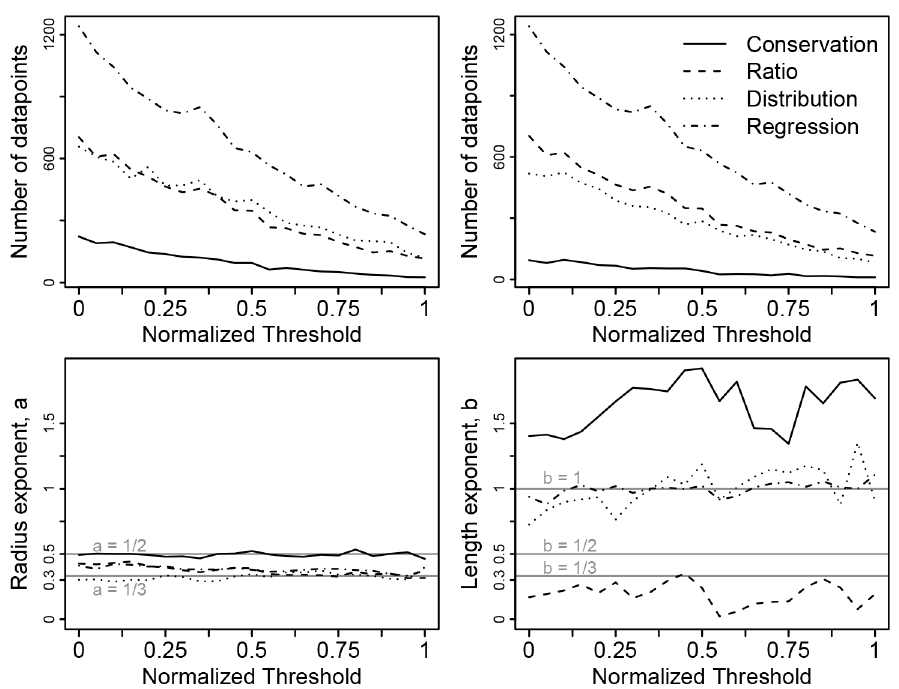
Fig 5. Sensitivity of the measured scaling exponents to the threshold intensity values that select which voxels are part of the vessel lumen. We normalized the threshold so that the minimum threshold (0.0) is the value used in our results and figures above, while the maximum threshold (1.0) is the largest value for which at least 30 vessel segments are visible. We re-scaled the threshold values because the raw value is different for each image. The top left panel shows the number of vessel segments used to calculate the four scaling exponents for vessel radius versus the normalized threshold value, as in the N column of Table 1. The top right panel shows the number of vessel segments used to calculate the four scaling exponents for vessel length versus the normalized threshold value, as in the N column of Table 1. For both of these top two panels, the number of data points decreases with threshold value as it must. The bottom left panel depicts how the four calculated scaling exponents for vessel radius vary with normalized threshold value. The bottom right panel depicts how the four calculated scaling exponents for vessel length vary with normalized threshold value. Horizontal lines indicate points of comparison to theory as described in Table